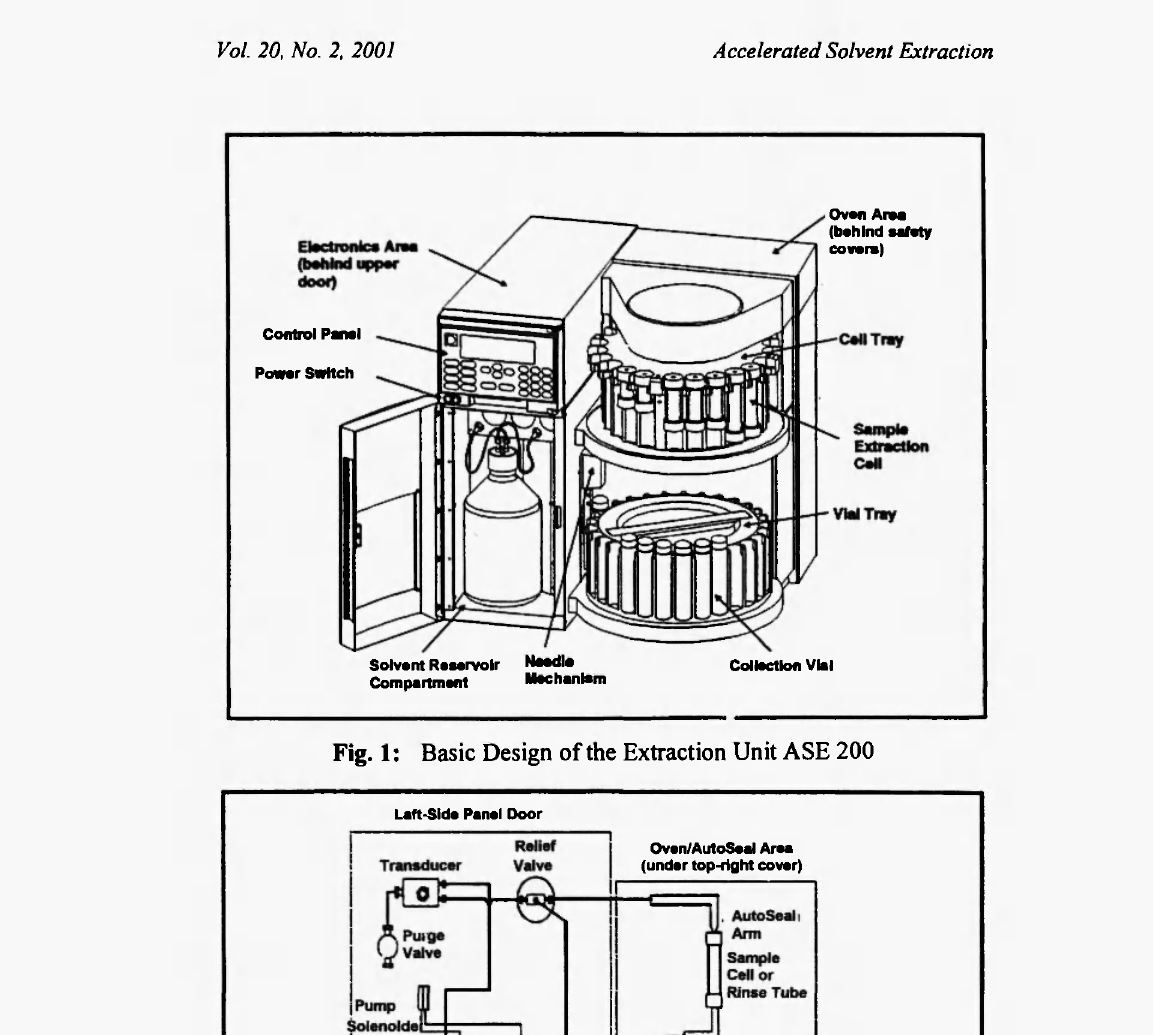
Fig. 1 : Basic Design of the Extraction Unit ASE 200